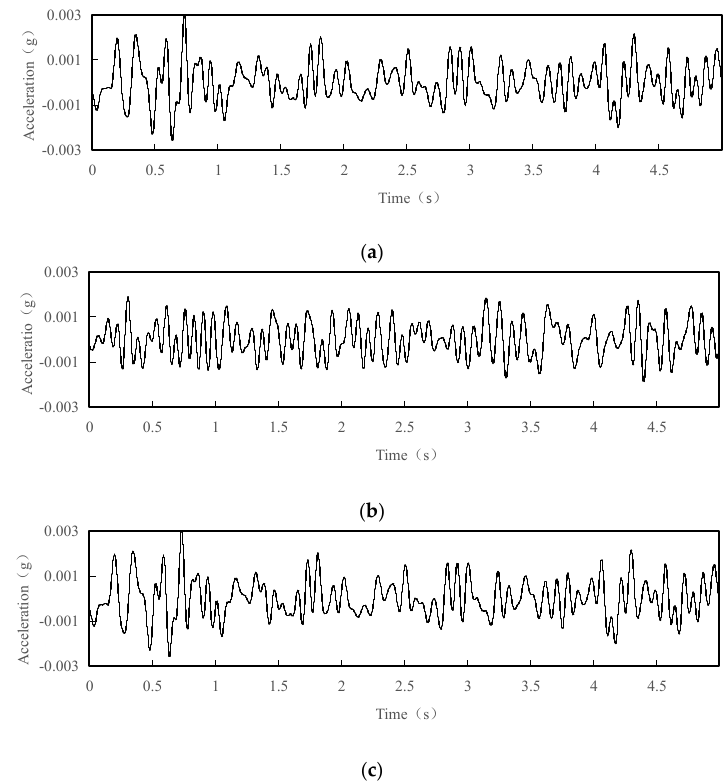
Figure 4. Acceleration time history curves with interval of 5 s of the test point 1 after filtering under normal conditions: ( a ) acceleration time history curve in the X direction after filtering; ( b ) acceleration time history curve in the Y direction after filtering; ( c ) acceleration time history curve in the Z direction after filtering.